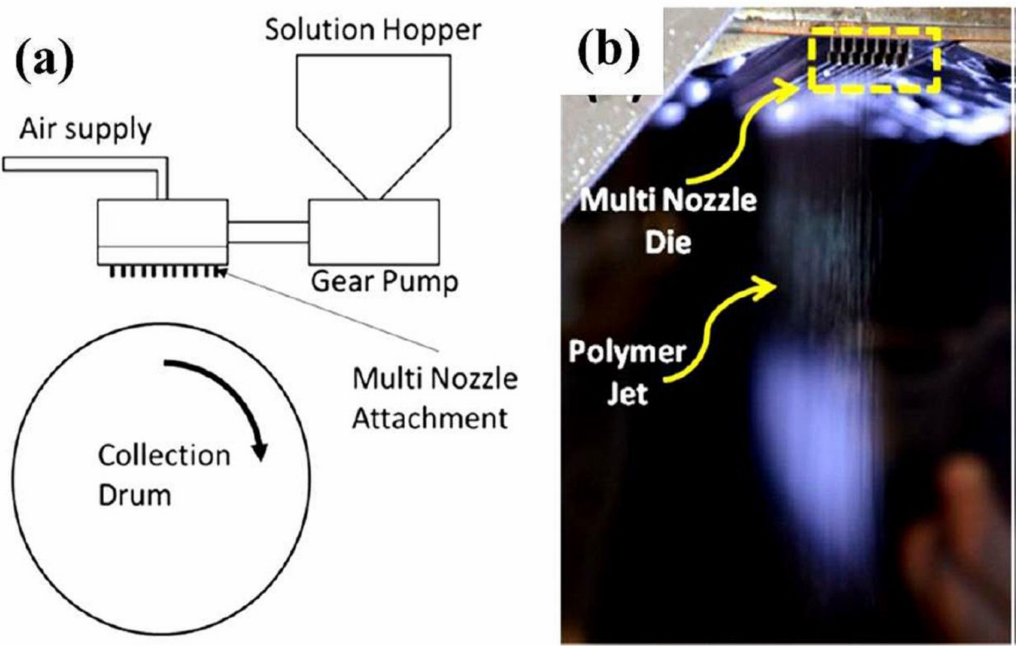
Figure 17. ( a ) Schematic of the industrial-scale solution blowing setup, as shown in Kolbasov et al., (2015); ( b ) actual multi-nozzle solution blowing process using BIAX die nosepiece. Reproduced with permission from ref. [47]. Copyright American Chemical Society,